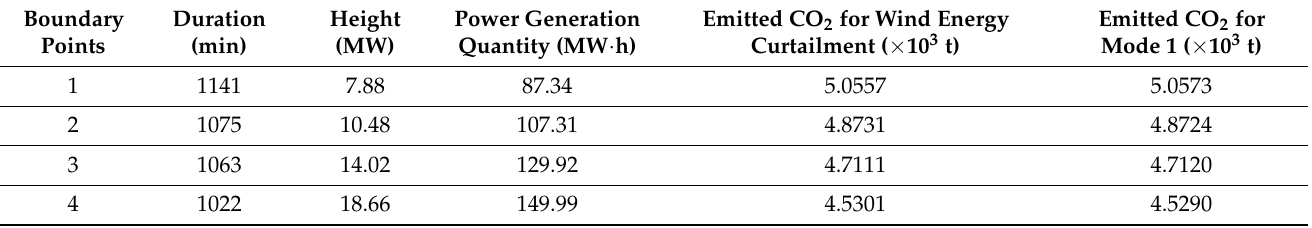
Table 5. Wind energy curtailment boundary with CO 2 net emission reduction as the decision